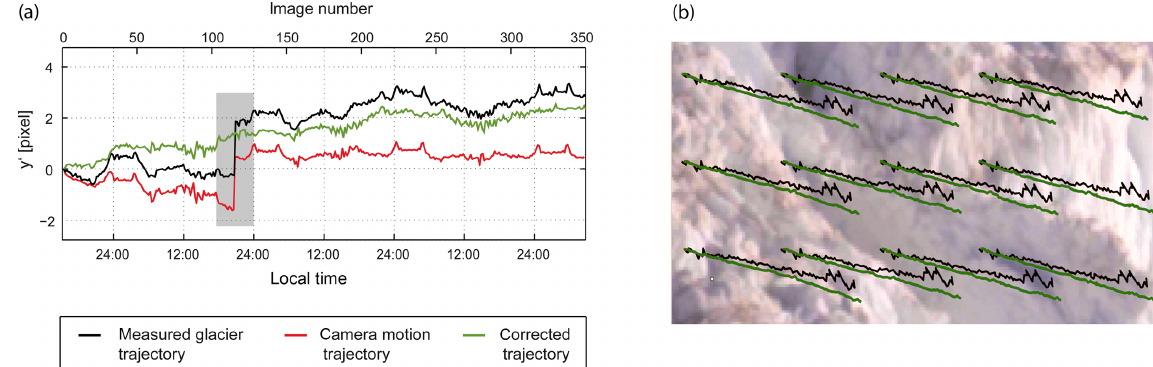
Figure 10. Application of camera movement compensation. (a) Shows the vertical component of a measured trajectory (black), the cam- era motion trajectory (red) and the corrected trajectory (green). The grey area indicates where a jump in the camera movement occurred. (b) A small subset of a sequence image is shown overlaid by some measured trajectories (tracked through a 24h image sequence).The origi- nally measured trajectories (black) clearly show fluctuations caused by camera motion. In contrast, the corrected trajectories (green) finally represent the smooth glacier movement.